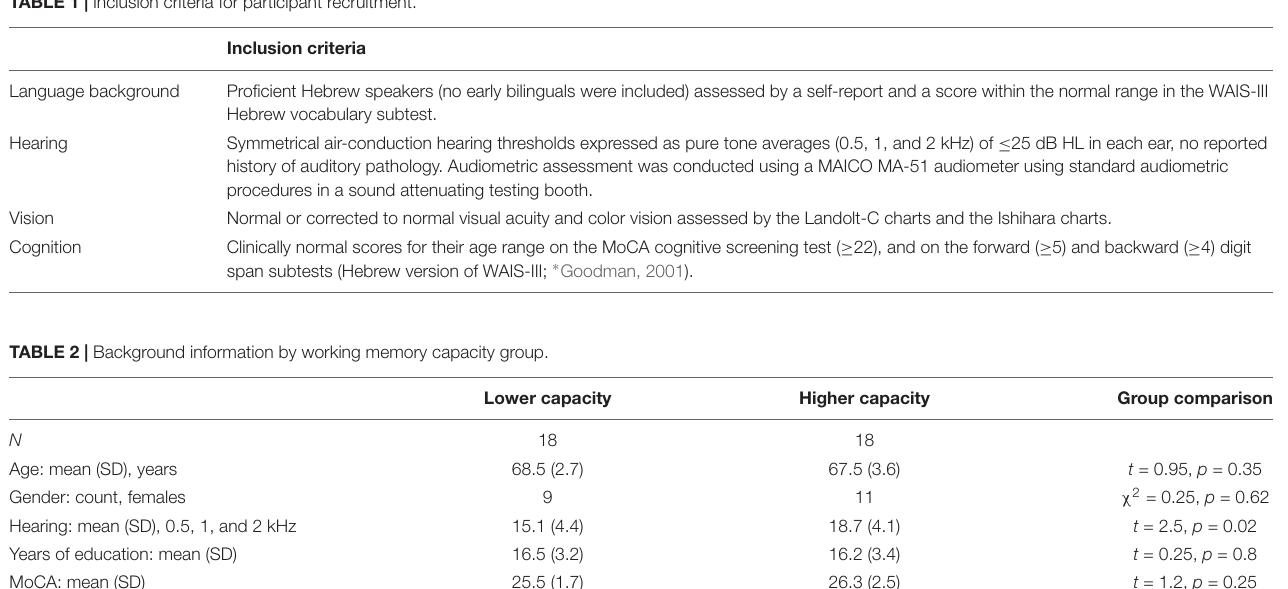
TABLE 1 | Inclusion criteria for participant recruitment.